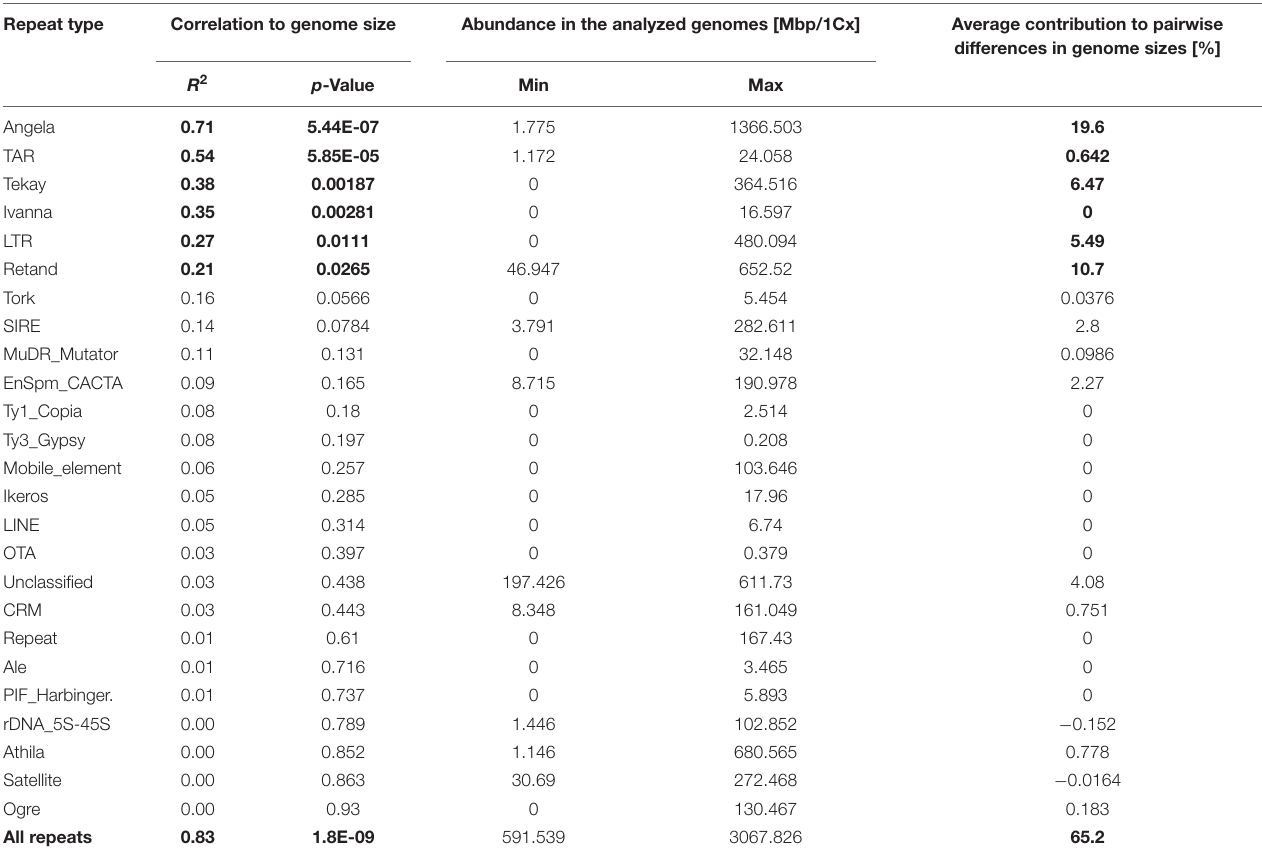
Only the most represented repeat types of Loliinae are shown. Significant values are highlighted in